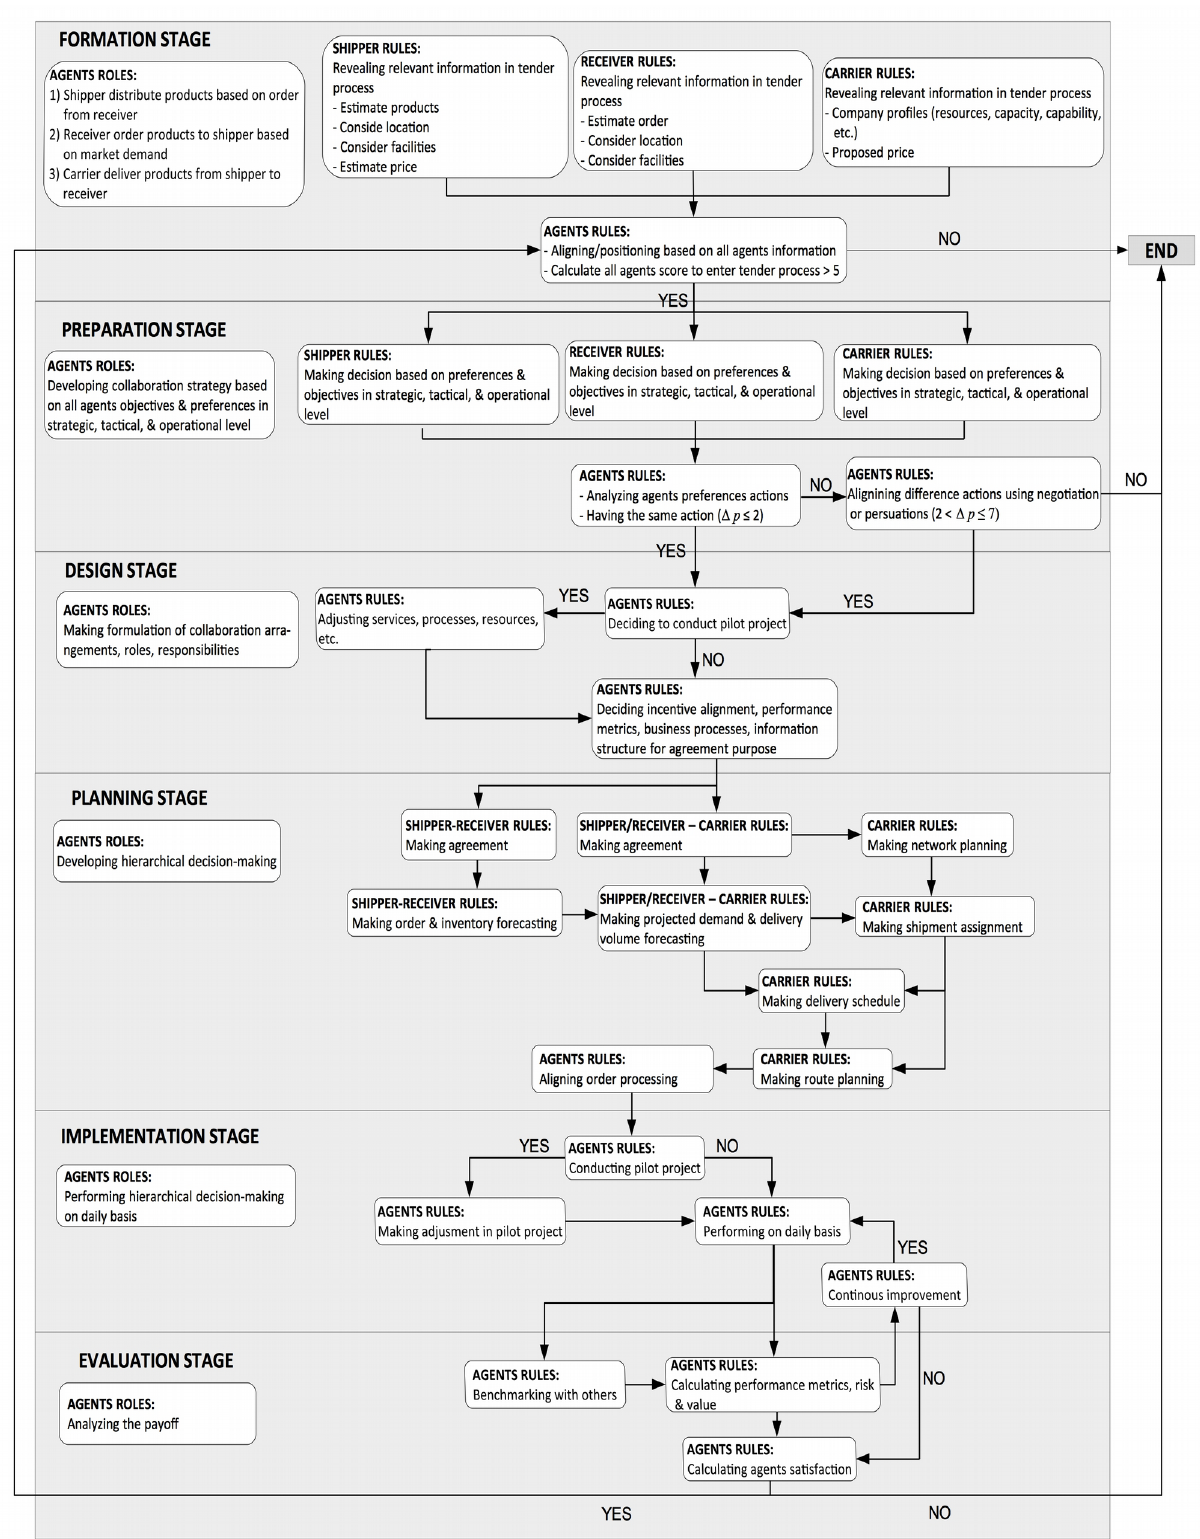
Figure 2. Rules and Roles